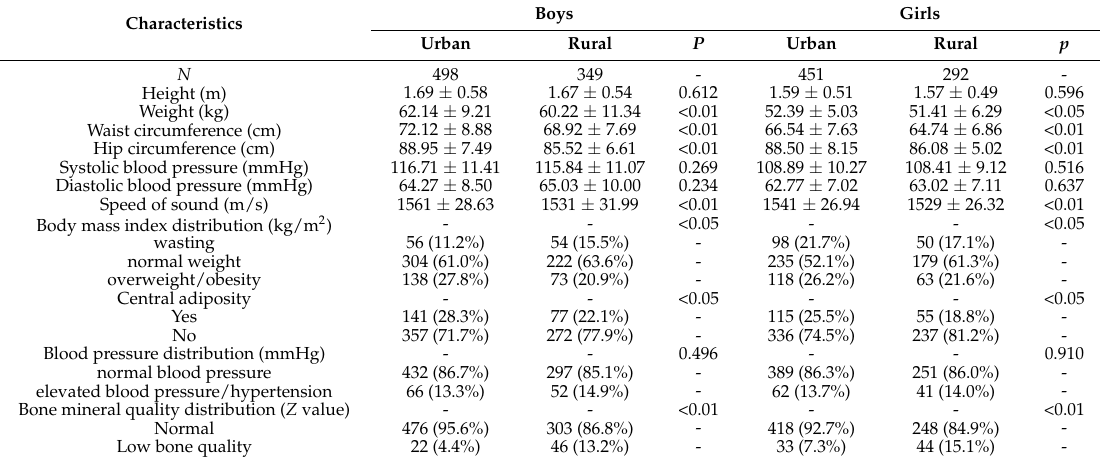
Table 4. Differences of basic characteristics between urban and rural